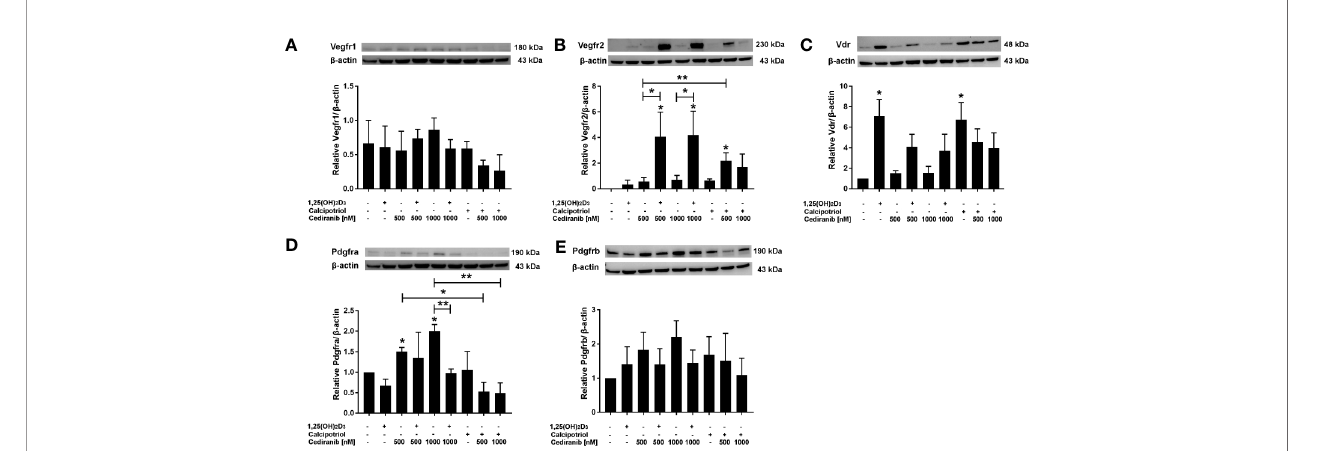
FIGURE 5 | The effect of 24-h preincubation with vitamin D analogs at 100 nM concentration on VEGFR1 (A) , VEGFR2 (B) , VDR (C) , PDGFRa (D) , and PDGFRb (E) protein level in A375 melanoma cells treated subsequently for 24 h with cediranib at 500 or 1,000 nM concentration. Protein levels were measured by Western blotting, with b -actin used as a control. Data are shown as mean from three independent experiments ± SEM. * p < 0.05 and ** p < 0.01 vs. untreated control or between the two groups indicated by the bracket.